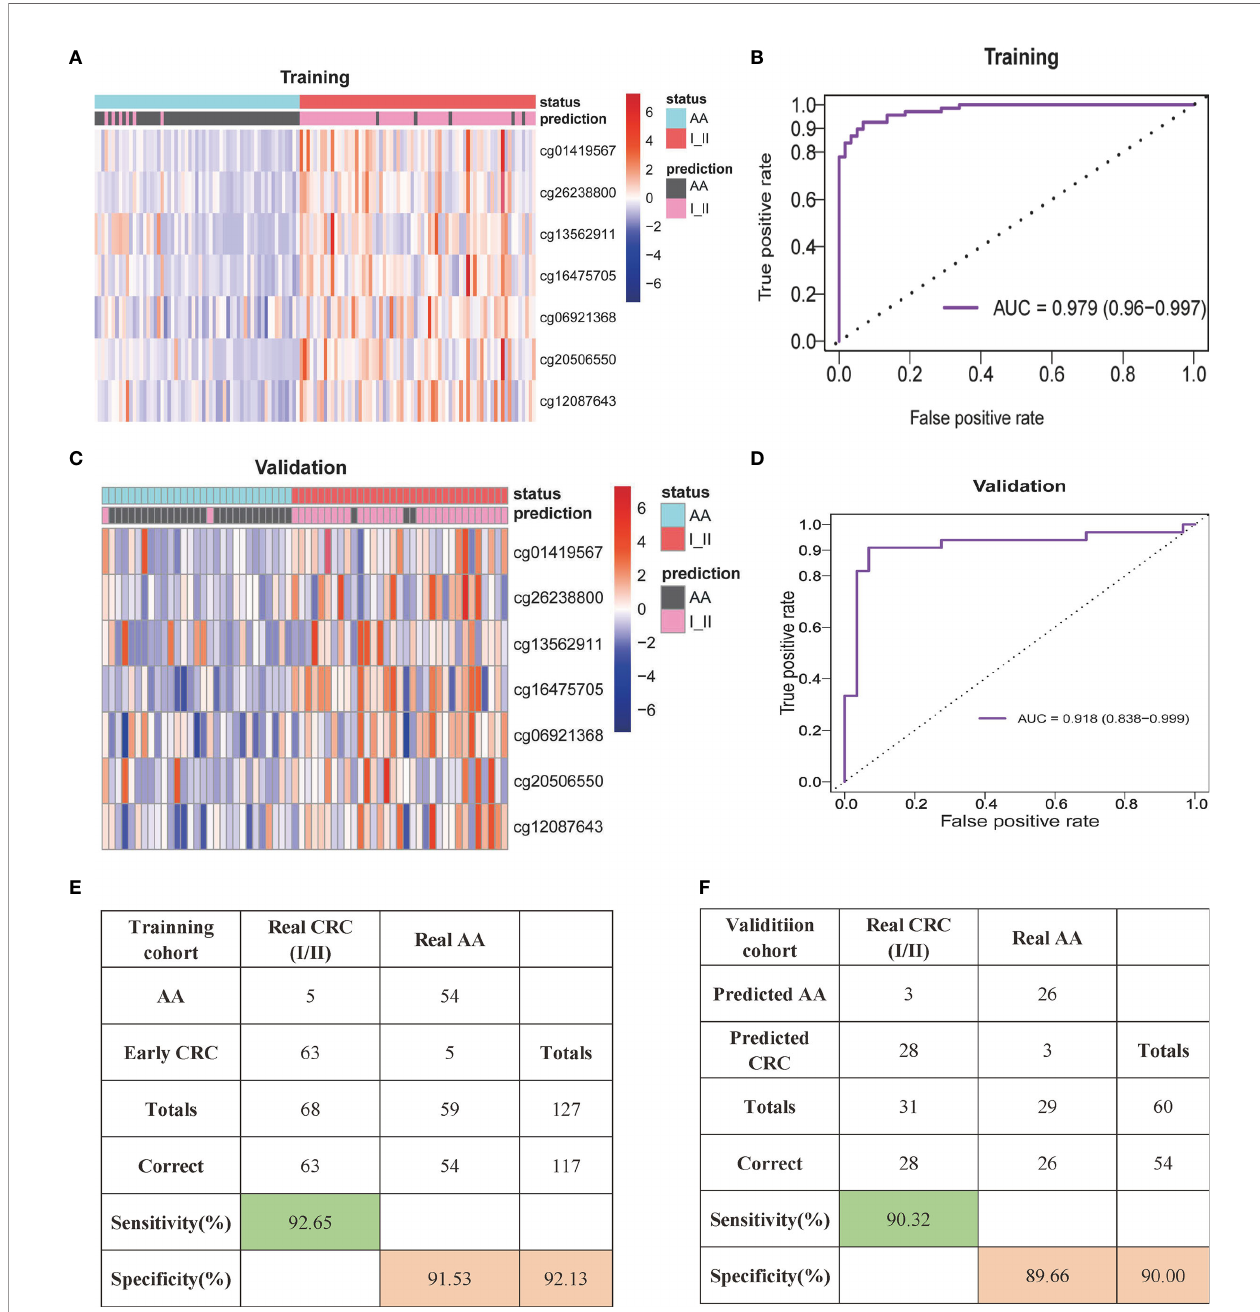
FIGURE 3 | cfDNA methylation analysis for early-stage CRC diagnosis. (A, B) Unsupervised hierarchical clustering of the seven selected markers between AA and early stage CRC in the training (A) and validation (B) cohorts. Each row represents an individual patient, and each column represents a CpG marker. (C, D) Receiver operating characteristic (ROC) curve and the related AUCs of the SDMBP model for diagnosing CRC in the training (C) and validation (D) cohorts. (E, F) Confusion matrices built from the SDMBP model in the training (E) and validation (F) cohorts. The beta values of the DMLs were normalized by the z score